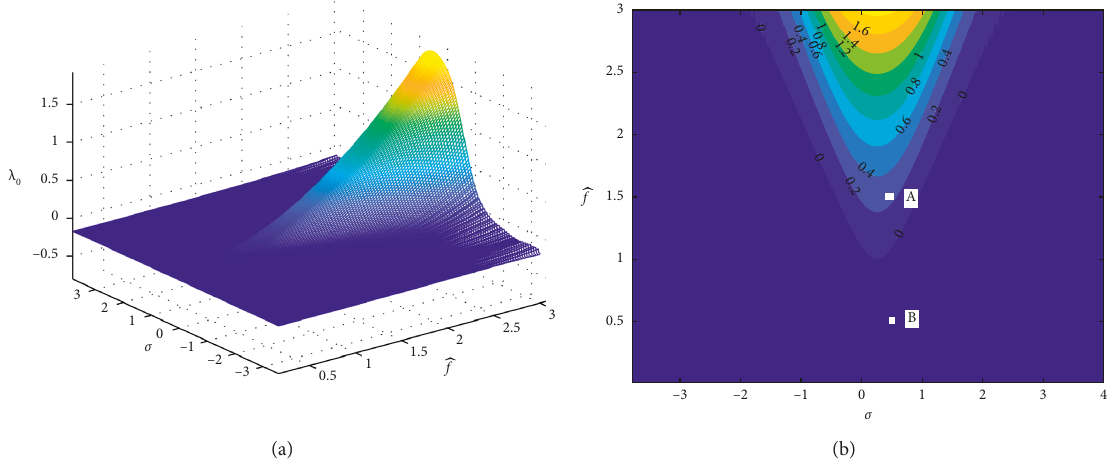
Figure 3: Largest Lyapunov exponents: (a) mesh surface; (b) isohypse curves.